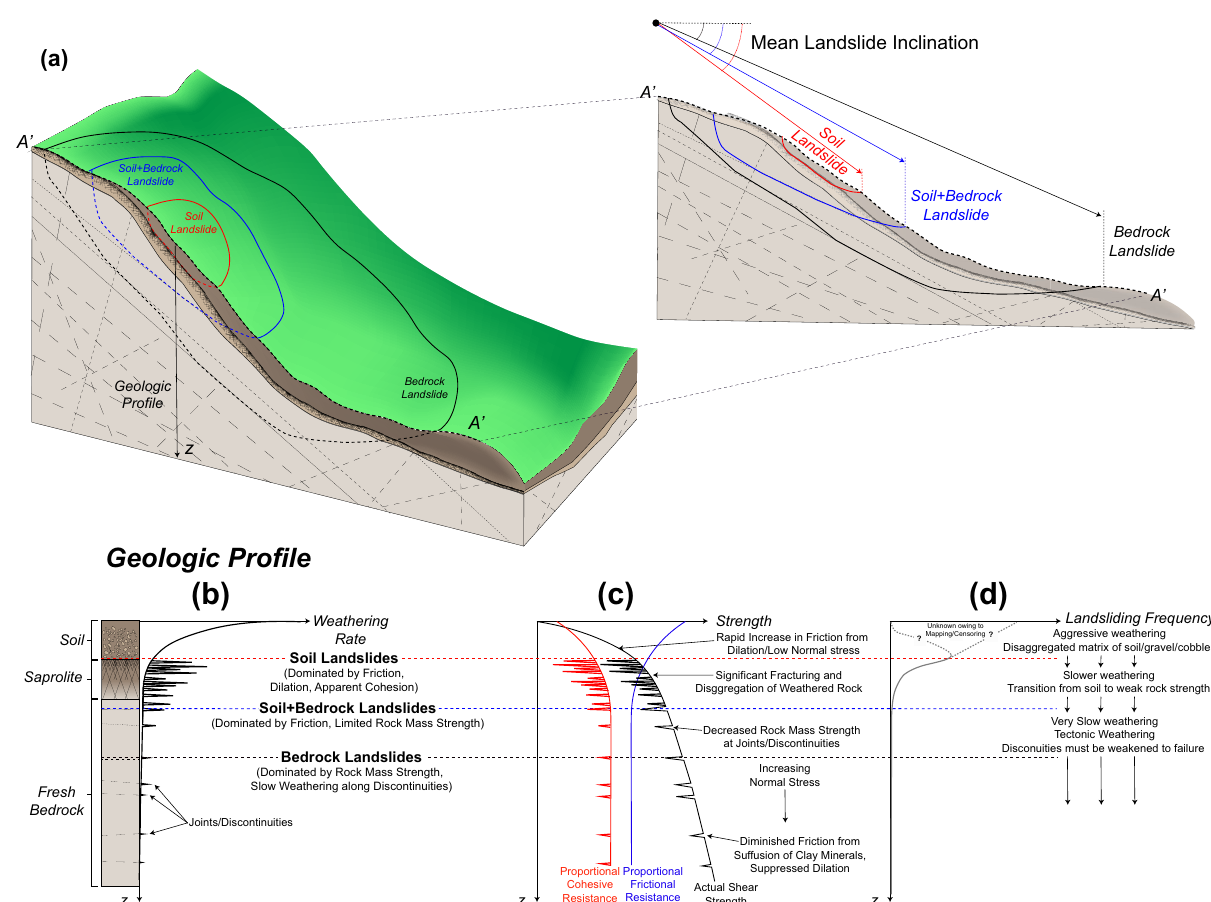
Fig. 4 | Conceptual relationship between landslide size, strength, and weath- ering. Weathering rates and processes control the relationship between landslide inclination, size, frequency, and strength. a Three general landslide characteristics are shown in the idealized geologic cross-section: deep, landslides predominantly inbedrock(blacklines),landslidesofmoderatedepththatencompassamixtureof soil and bedrock (blue lines), and shallow landslides, typically constrained within thesoil(redlines).Thelandslideboundaryandshearsurfaceareshowninboldand dashed lines, respectively. A comparison of landslide inclinations shows ( b ) an idealized transition between steeper soil landslides to more gentle bedrock land- slides with increasing depth. Soil landslides are often constrained to localized pockets of steep terrain. While thick bedrock landslides may encompass thissame steep terrain, suf fi cient shear stress is necessary to overcome rock mass strength (predominantly cohesive), envelop localized weaknesses and/or suppress friction, and cause failure, consequently deepening the critical shear surface depth and encompassingmoregentleterrain. c Theseconditionscanonlybe accommodated